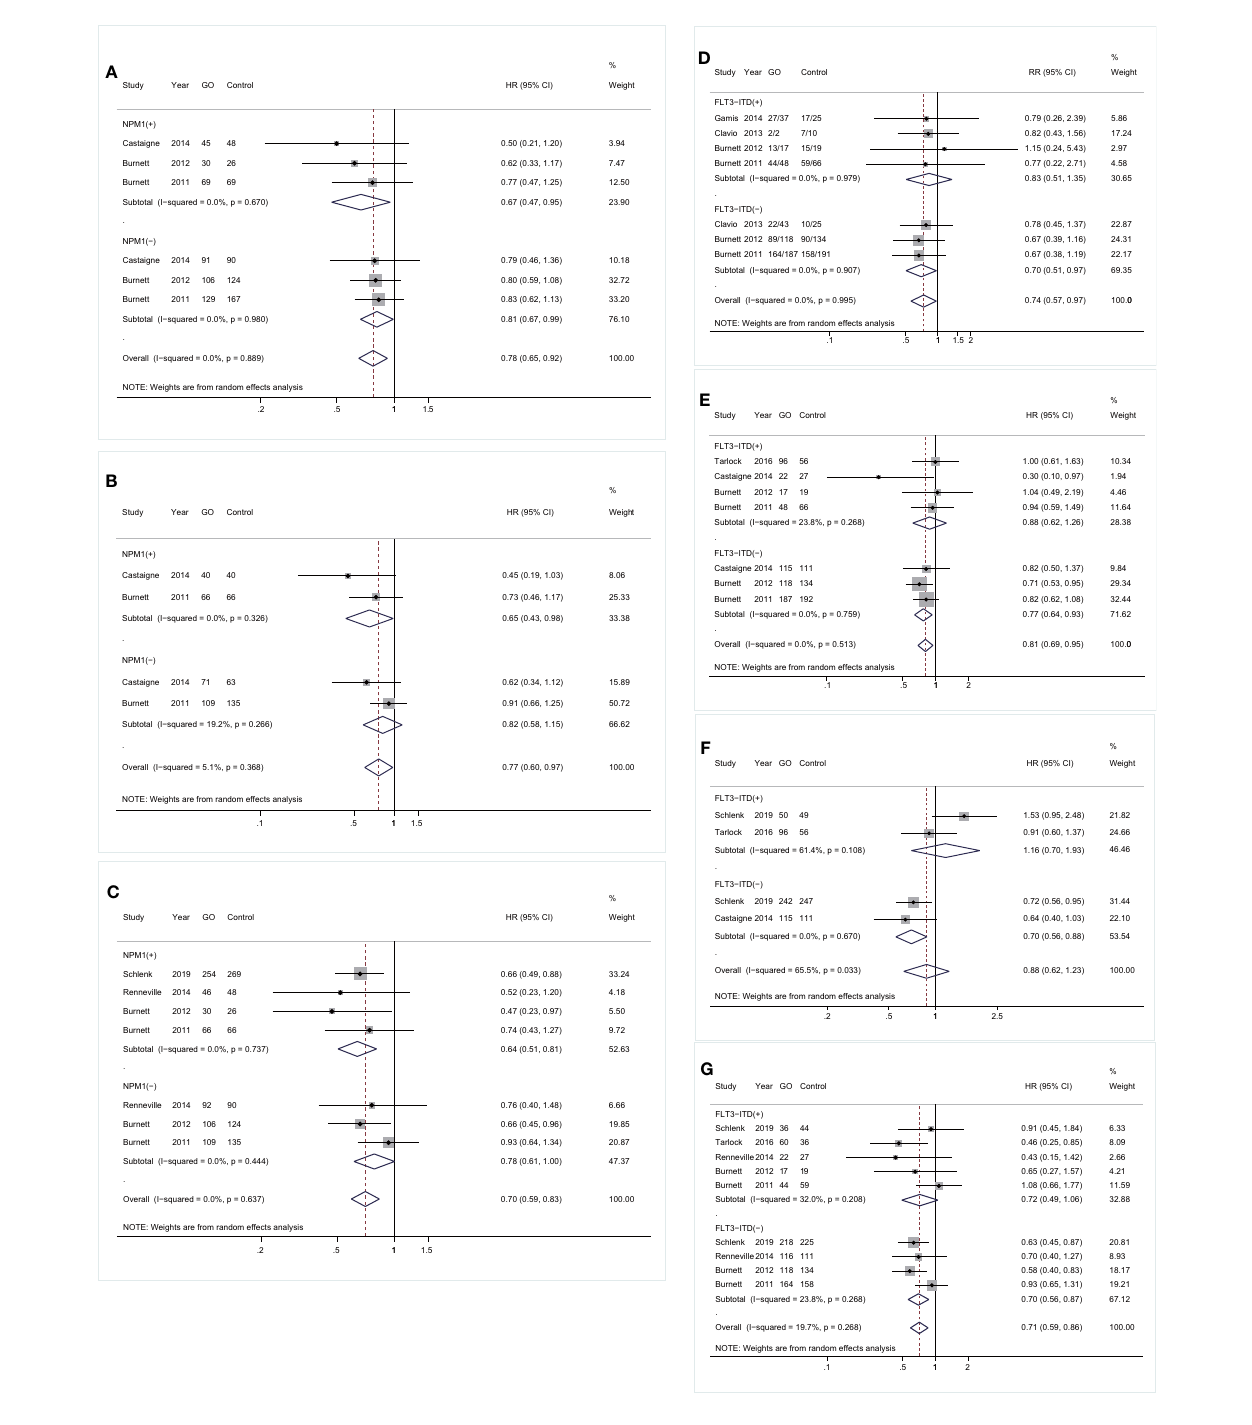
FIGURE 3 | Prognostic subgroup analyses regarding NPM1 and FLT3-ITD mutations. (A) OS subgrouped by NPM1 mutational status. (B) RFS subgrouped by NPM1 mutational status. (C) CIR subgrouped by NPM1 mutational status. (D) CR subgrouped by FLT3-ITD mutational status. (E) OS subgrouped by FLT3-ITD mutational status. (F) EFS subgrouped by FLT3-ITD mutational status. (G) CIR subgrouped by FLT3-ITD mutational status. The diamonds represent the overall summary RR and HR estimates with 95% CI. GO, gemtuzumab ozogamicin; CR, complete remission; OS, overall survival; EFS, event-free survival; RFS, relapse-free survival; CIR, cumulative incidence of relapse; RR, relative risk; HR, hazard ratio; 95% CI, 95% con fi dence interval; NPM1, nucleophosmin 1; FLT3-ITD, FMS-like tyrosine kinase 3 internal tandem